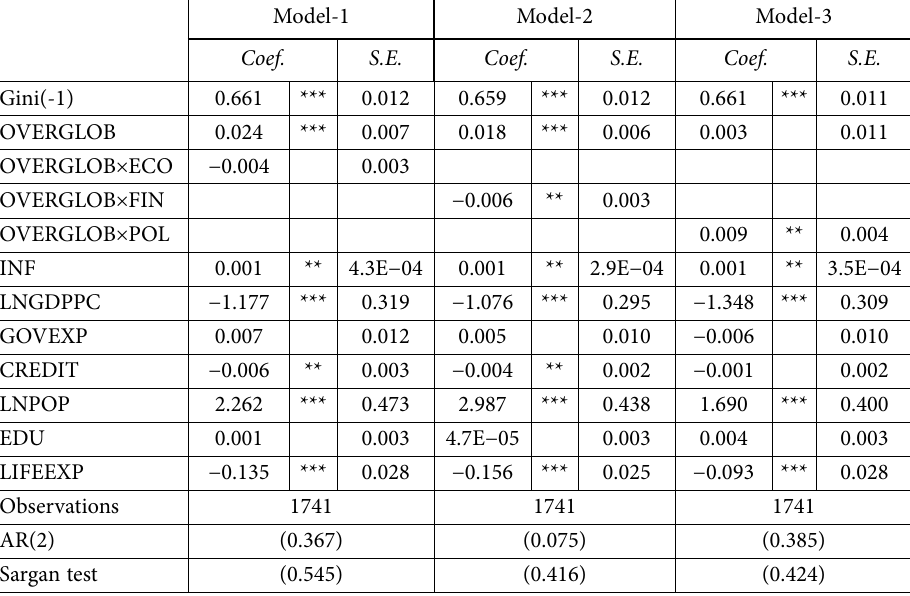
Table 2. The effects of overall globalization under separate aspects of country risk Model-1 Model-2 Model-3 Coef.